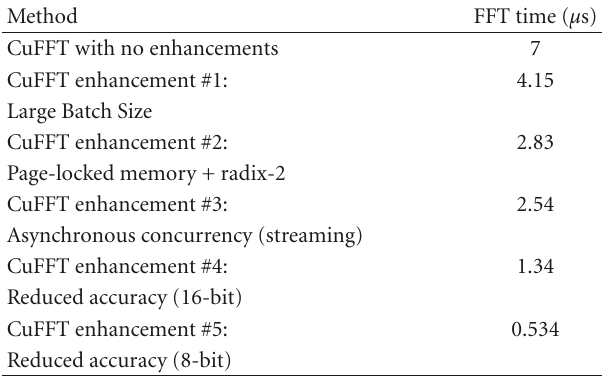
Table 4: Performance summary of CuFFT and proposed methods to improve